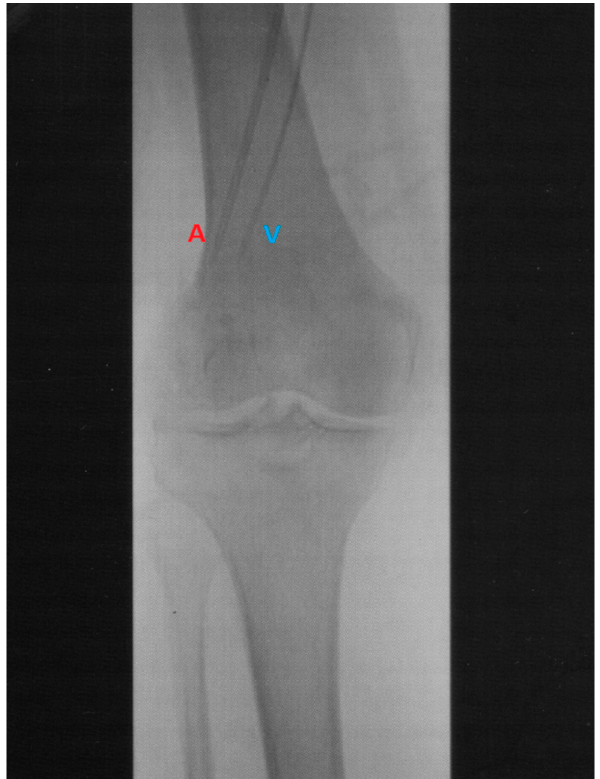
Figure 2. Angiogram of the arterial (A) and venous (V) catheters positioned in a lower limb with the tips reaching into the mid-popliteal vessels just proximal to the knee.